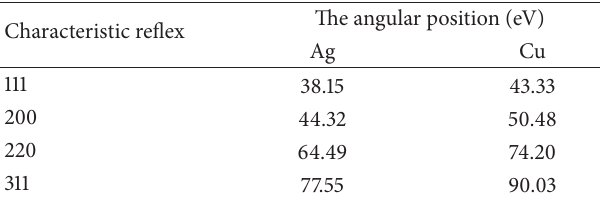
Table 2: XRD results: the angular position of characteristic reflexes for silica containing immobilized nanosilver or